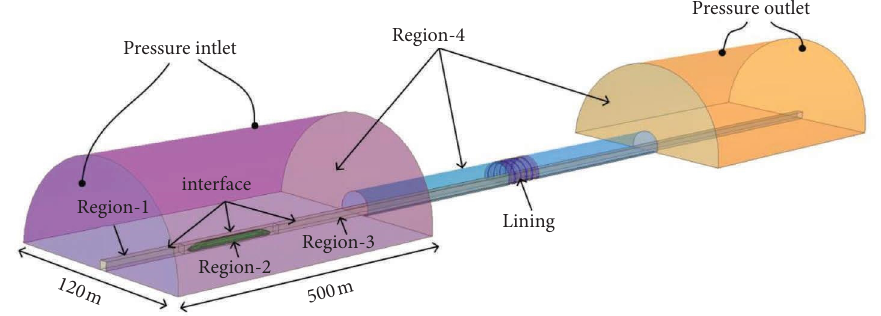
Figure 2: Computational domain and boundary Table 1: Grid quantity and micropressure wave. Grid quantity